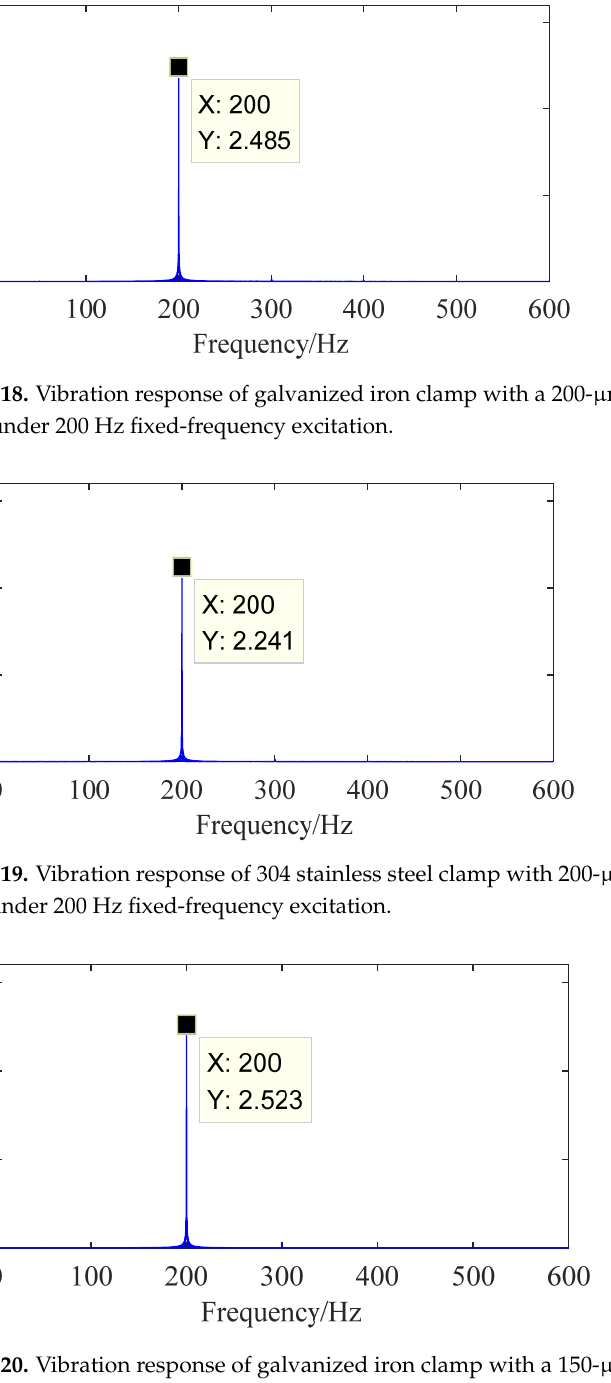
Figure 17. Vibration response of 304 stainless steel clamp with a 200- μ m-thick hard coating of 8% Y 2 O 3 -Z r O 2 under 200 Hz fixed-frequency excitation.